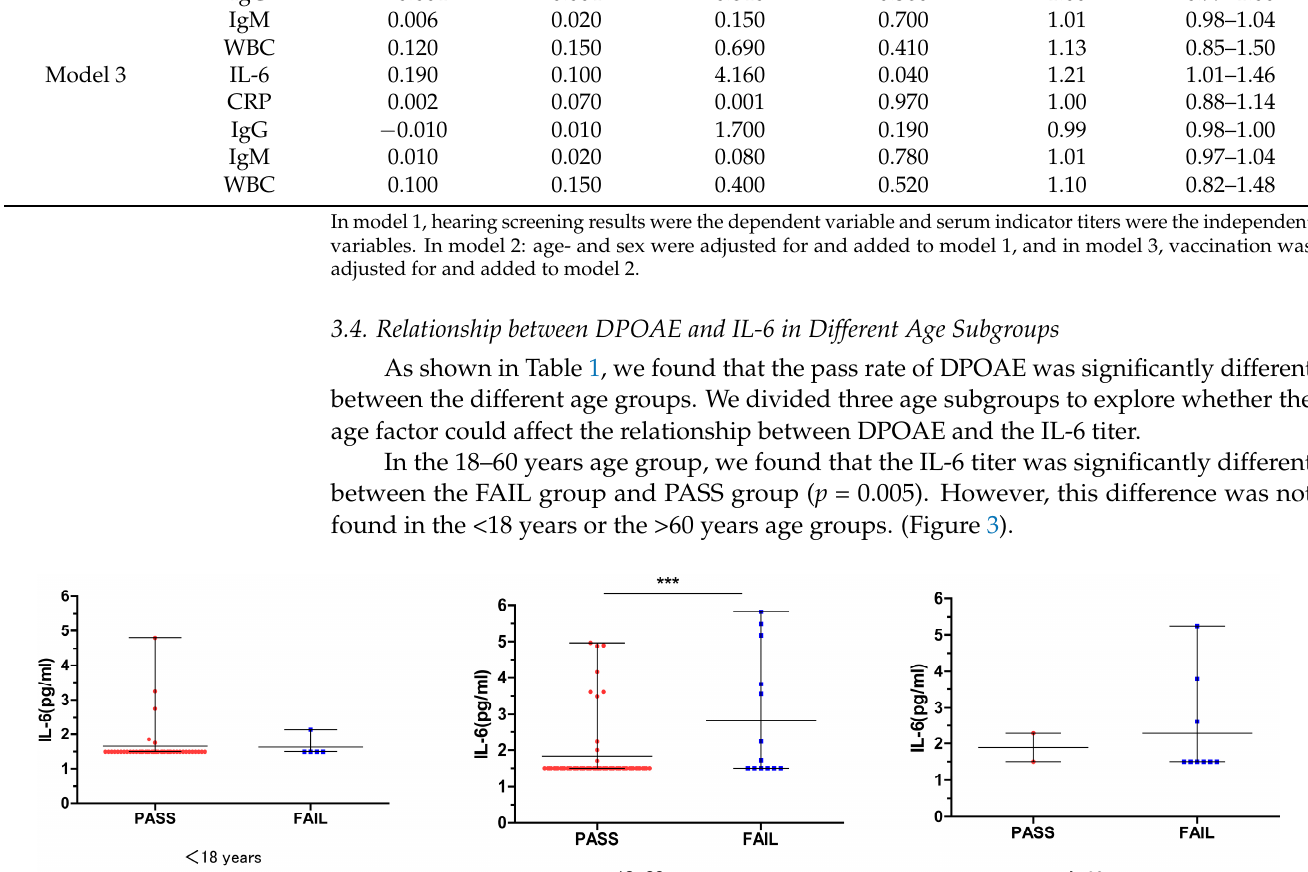
Table 3. Multivariate logistic regression analysis of IL-6 in the different age groups of DPOAE re- sults. Model